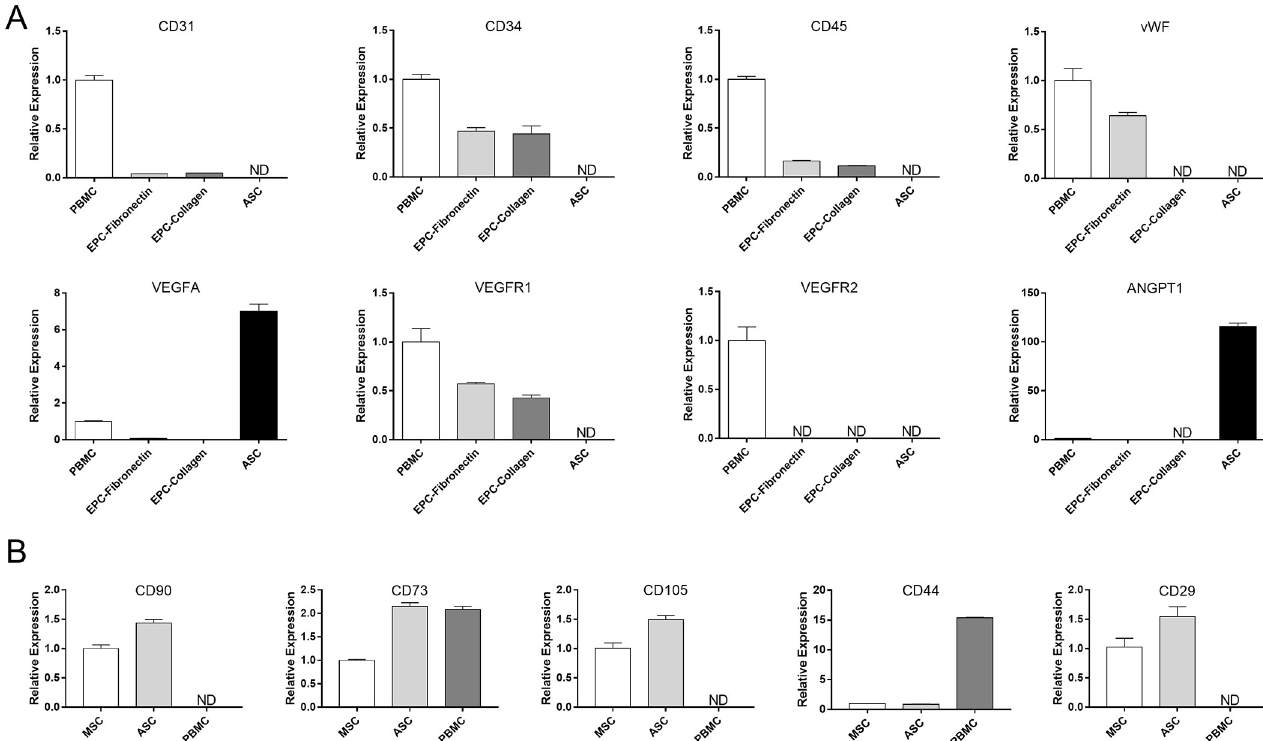
Fig 2. Molecular phenotyping of EPCs and ASCs isolated from rabbits. ( A) The relative expression of surface markers and angiogenic factors in PBMCs, EPCs, and ASCs was evaluated with qPCR. (B) The transcription of key stemness markers in ASCs were evaluated with qPCR. The rabbit bone marrow mesenchymal stem cells (MSC) and rabbit PBMC were used as controls. Levels below the detection limit are depicted as ND. Data are expressed as mean ± standard errors of the mean